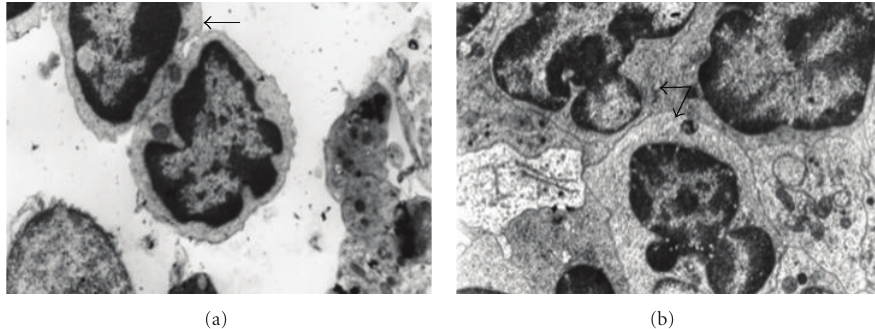
Figure 8: Spleen lymphocytes’ nuclear changes after V 2 O 5 exposure. (a) In control animal’s nuclear morphology, regular ultrastructure in lymphocytes is observed (7000x) (arrow). (b) Vanadium exposure produces alterations in lymphocyte’s nuclear morphology similar to the changes observed in malignant cells (8000x) (arrows).